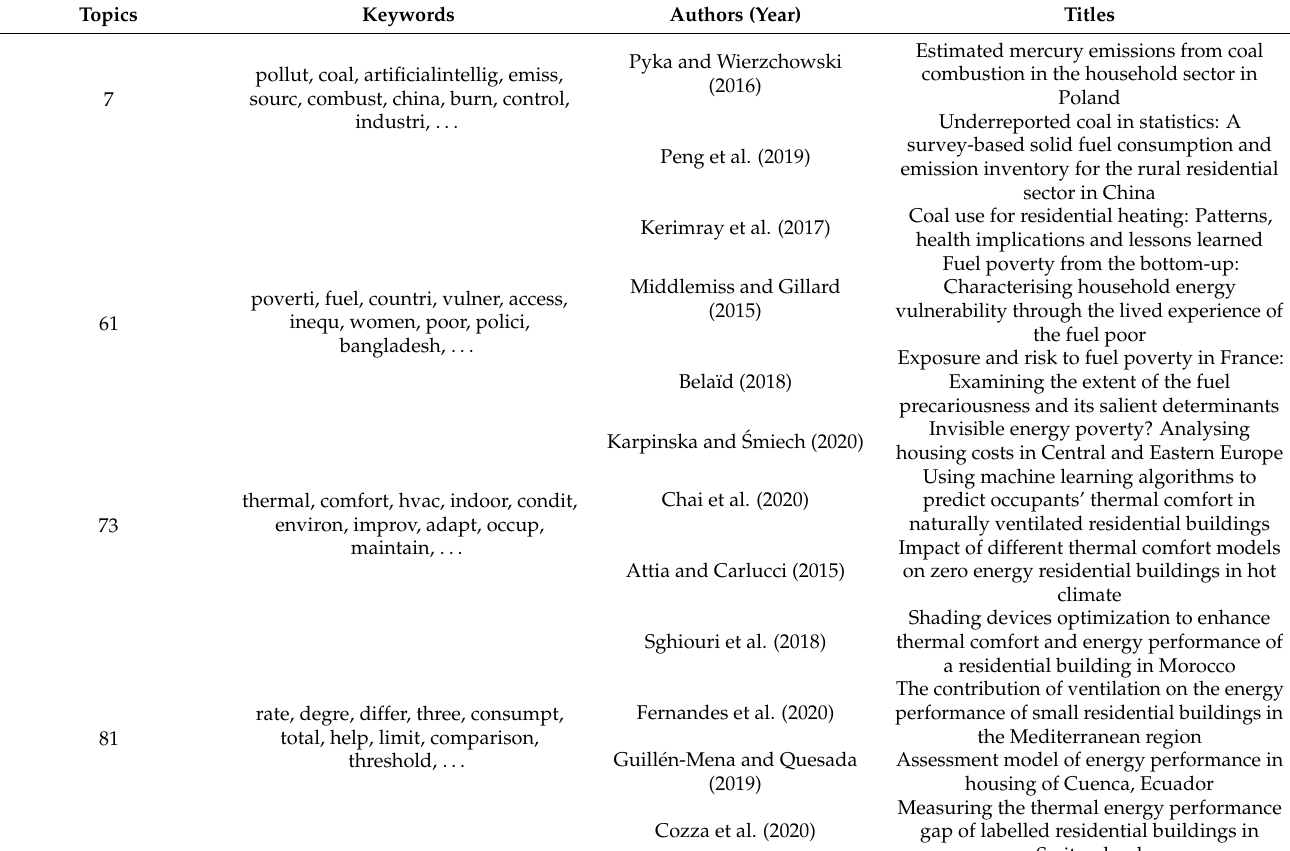
Table 4. Relevant documents with Weak signal topics 1